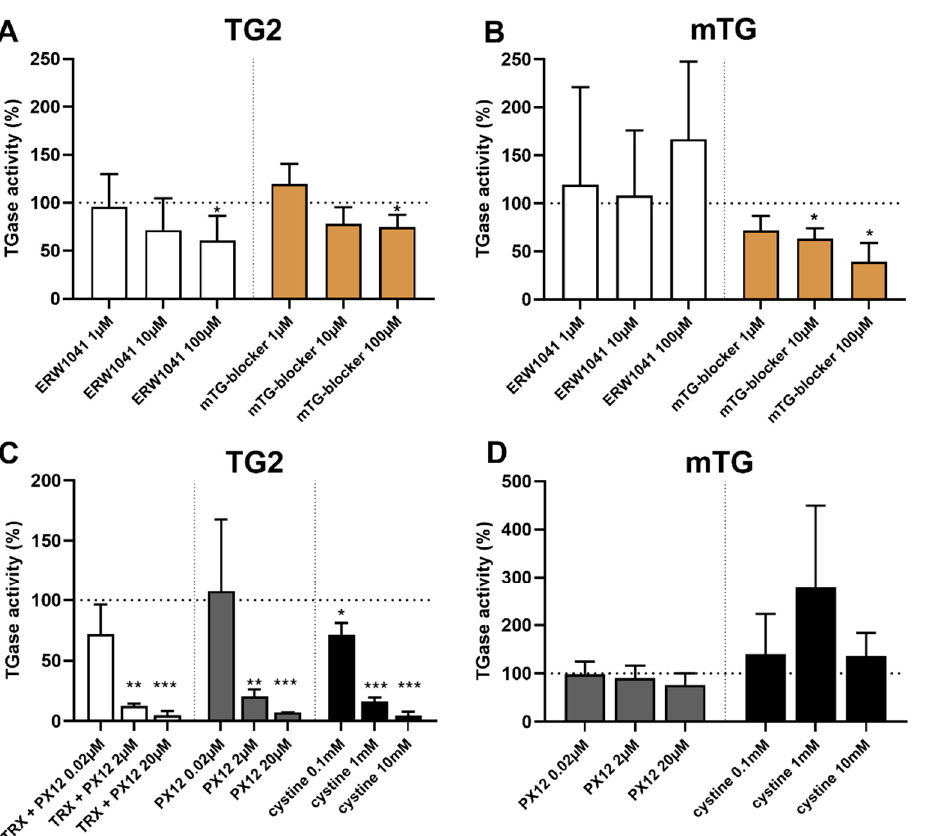
Figure 4. Effect of exogenous competitive and oxidative inhibitors on transglutaminases. ( A ) The competitive inhibitor ERW1041 selectively reduced TG2 activity at a dose of 100 µ M. The competitive mTG-blocker only showed minor inhibition of TG2 at a dose of 100 µ M. ( B ) mTG activity was not decreased by the competitive TG2 inhibitor ERW1041. Competitive mTG-blocker showed a strong and dose-dependent inhibition of mTG-mediated. ( C ) TRX was used at a 50-fold molar excess. Thioredoxin-mediated activation of TG2 could be abolished by PX12 at doses 2 µ M and 20 µ M. PX12 displayed a direct inhibitory effect on TG2 activity at 2 µ M and 20 µ M. L-cystine significantly reduced TG2 activity at all doses tested. ( D ) PX12 and L-cystine did not show any significant dose-dependent effect on microbial transglutaminase (mTG) activity. Data are shown as mean ± standard deviation.* p < 0.05, ** p < 0.01, *** p < 0.001.